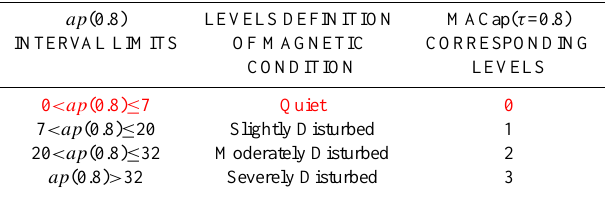
Table 2. Correspondence between the ap (0.8) values and four lev- els of magnetic activity defining the MACap.